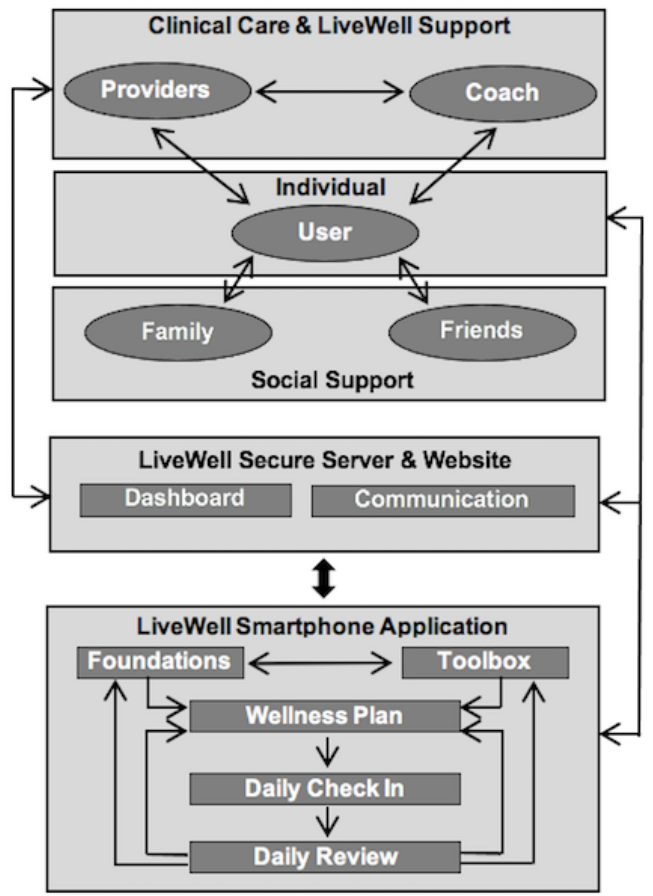
Figure 1. Intervention